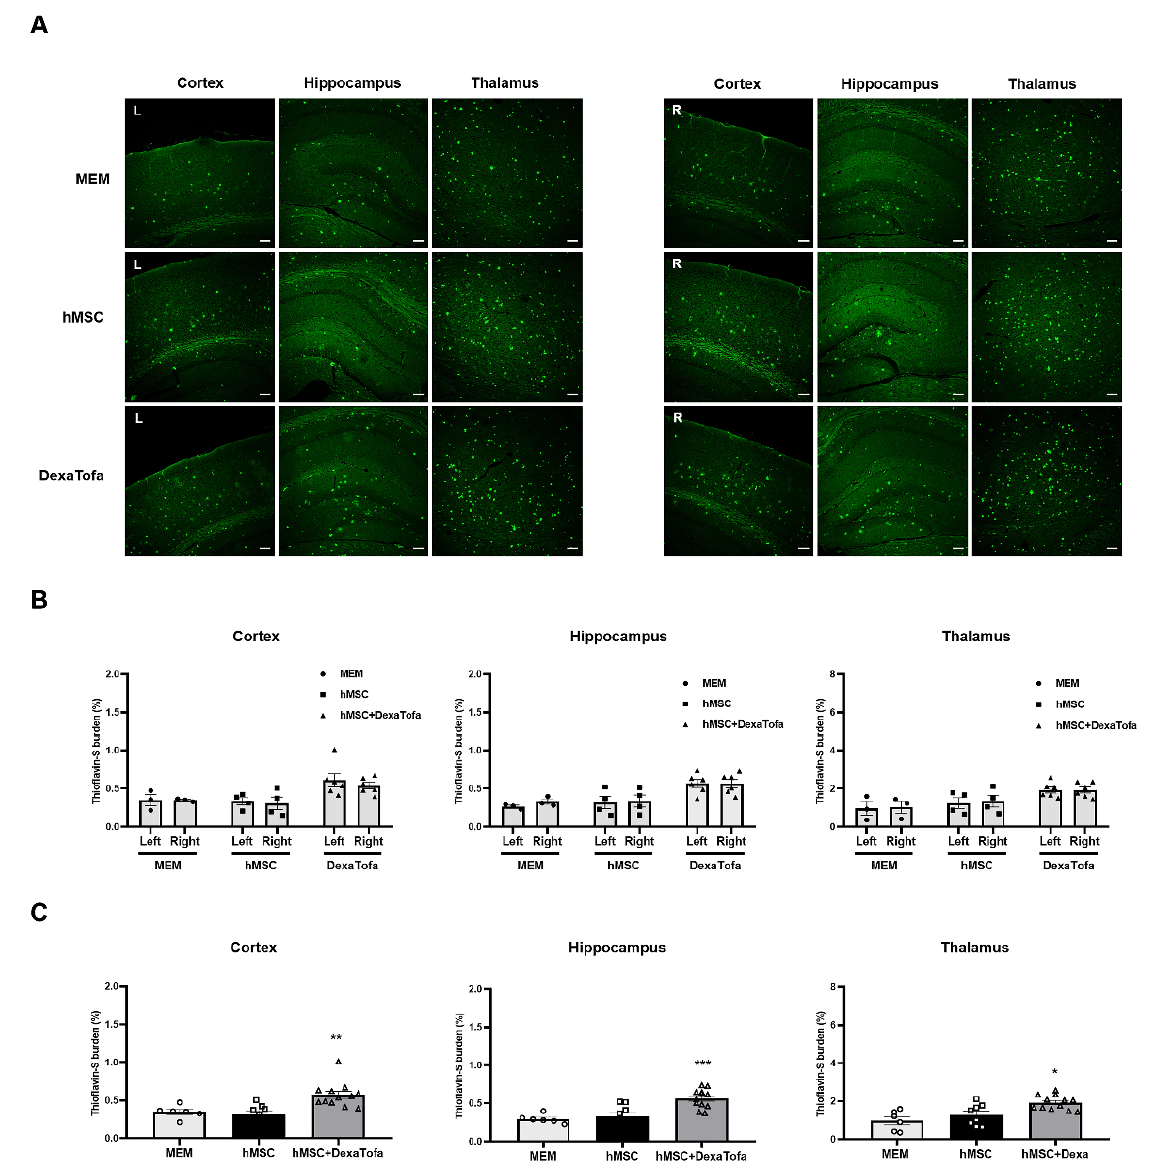
Figure 8. Thioflavin-S staining of the cortex, hippocampus, and thalamus of 5xFAD mice. ( A ) Repre- sentative Thioflavin-S-stained tissue images of the MEM ( n = 3), hMSC ( n = 4), and hMSC+DexaTofa ( n = 6) groups were acquired via a confocal microscope. Green dots (fluorescence signal) indicate the location of amyloid plaques. Scale bar for each image = 100 µ m. ( B ) Thioflavin-S burden % of the left (L) and right (R) hemispheres were quantitated for the cortex, hippocampus, and thalamus. Differences between the left and right hemispheres were not statistically significant for all 3 regions (mean ± SEM, two-way ANOVA, Tukey’s multiple comparison). ( C ) Data collected from the left and right hemispheres were combined and averaged for each region Statistical significance is defined as * p < 0.05, ** p < 0.01, *** p < 0.001 vs. hMSC; mean ± SEM (one-way ANOVA, Dunnett’s multiple comparison).